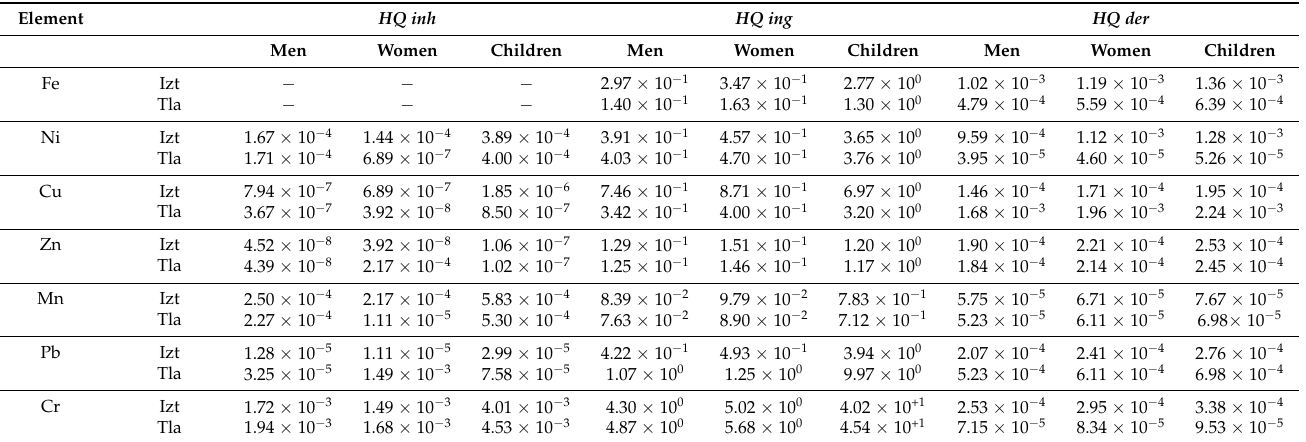
Table 5. Risk assessment results for inhalation, ingestion, and dermal absorption of PM 10 at the Iztapalapa and Tlalnepantla